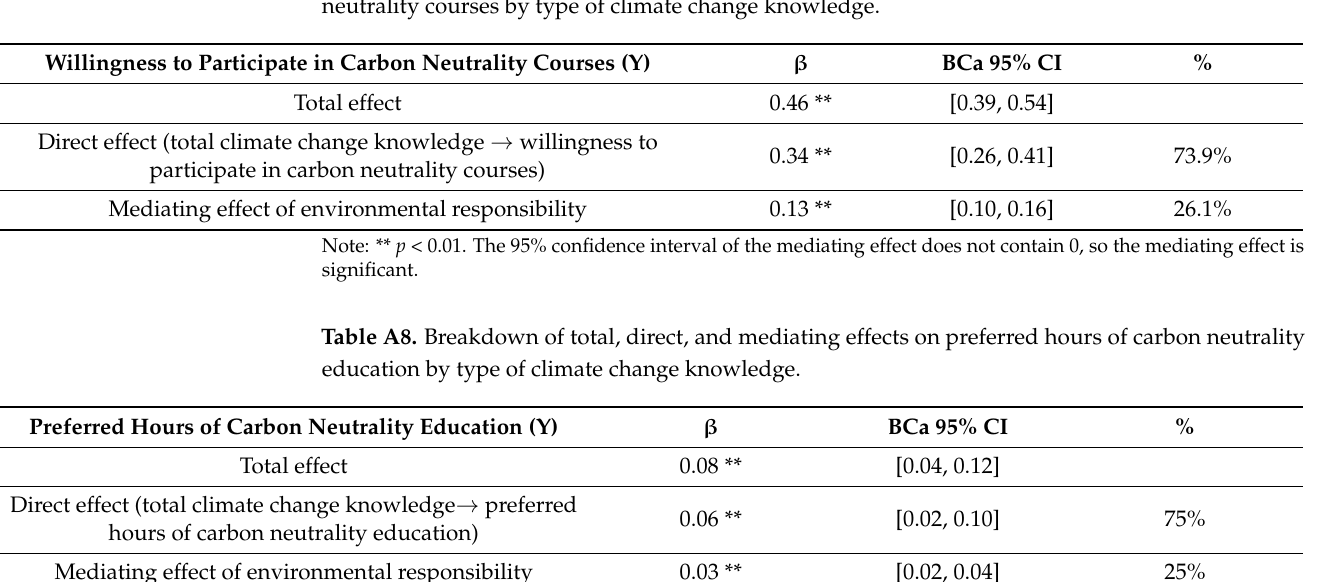
Table A7. Breakdown of total, direct, and mediating effects on willingness to participate in carbon neutrality courses by type of climate change knowledge.